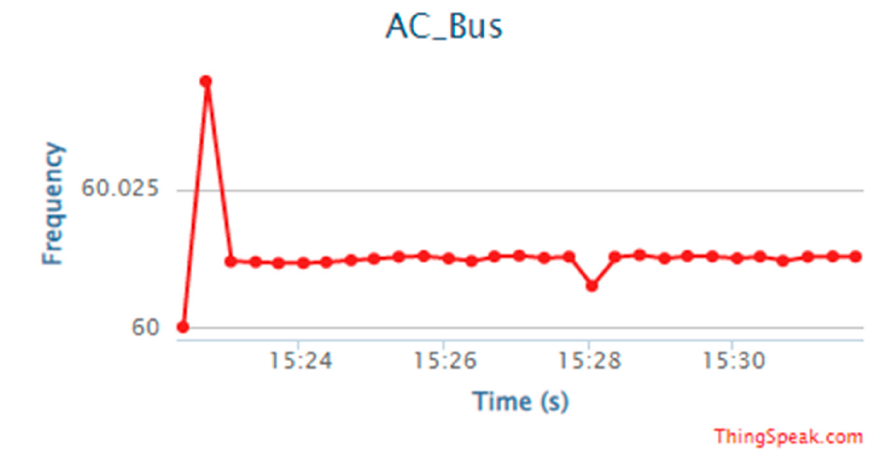
Figure 17. The measured frequency at the AC bus.